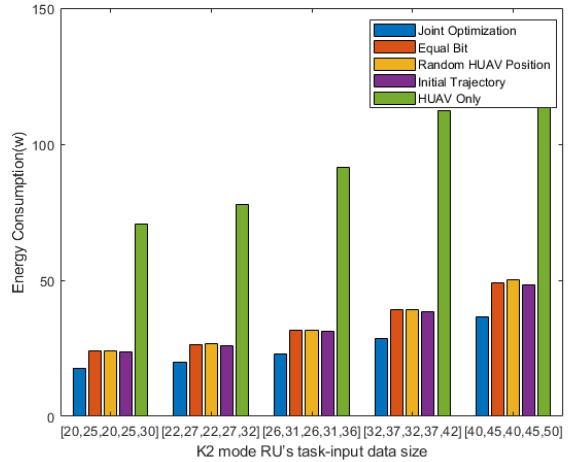
Figure 2. Optimized trajectory of the UAV under different flight periods.